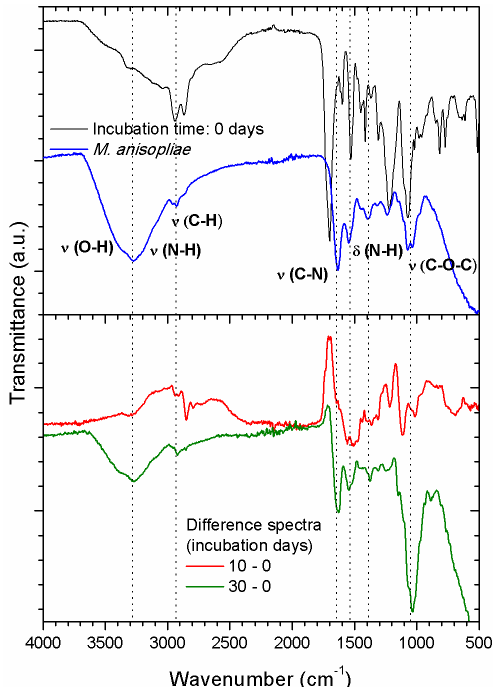
Figure 8. FTIR-ATR spectra of PU films treated with UV in the presence of AA vapors for 30 min without incubation ( top ) along with their difference spectra ( bottom ) and after incubation for 10 and 30 days. The FTIR-ATR spectrum of the fungus without any polymer is shown also on top together with the main signal assignments. The spectra were slightly moved in the vertical direction for better presentation.